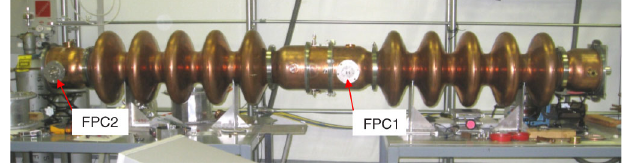
FIG. 17. The HOM damper ring with capacitive probes be- tween two copper cavities.